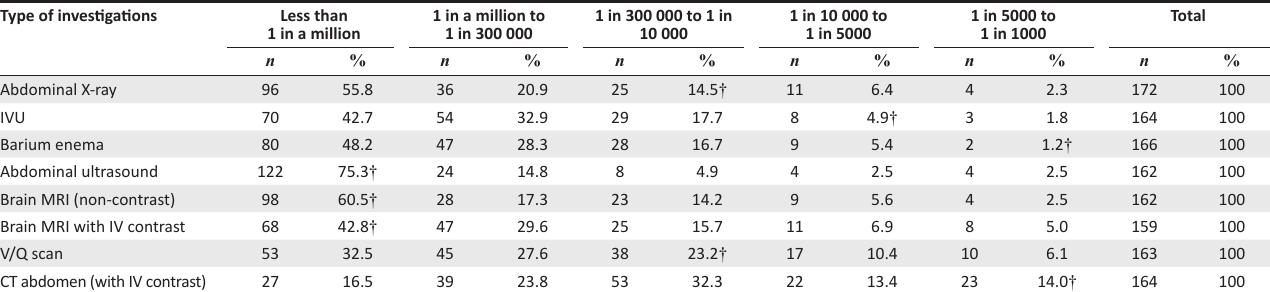
TABLE 4: The number of doctors who knew the risk of inducing fatal cancer from common but more complex imaging procedures. Type of investigations